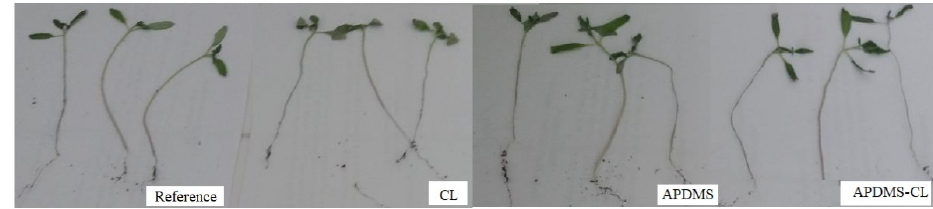
Figure 9 . Dry and green biomass quantities of tomato plants . Figure 10 represents the dry tomato plants for all of the samples three days after harvest.